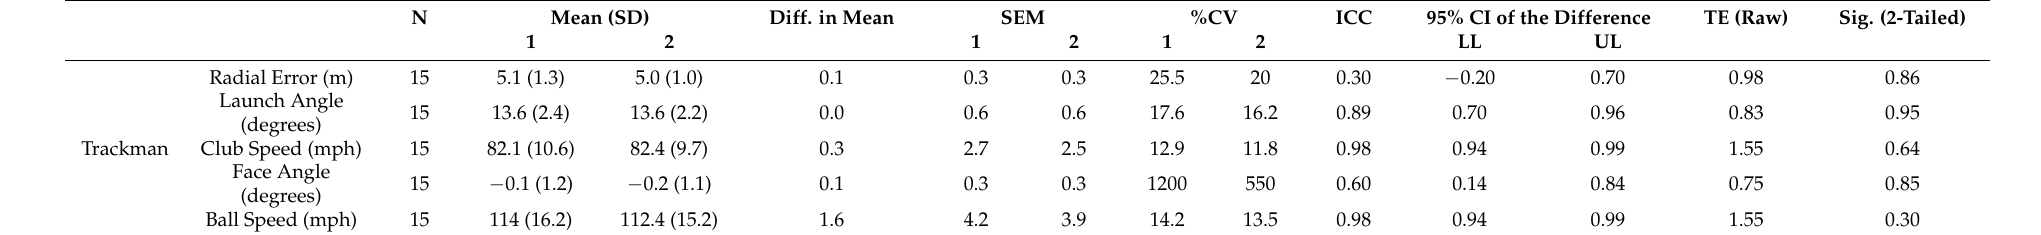
Table 1. Reliability of launch monitor swing and ball parameters.